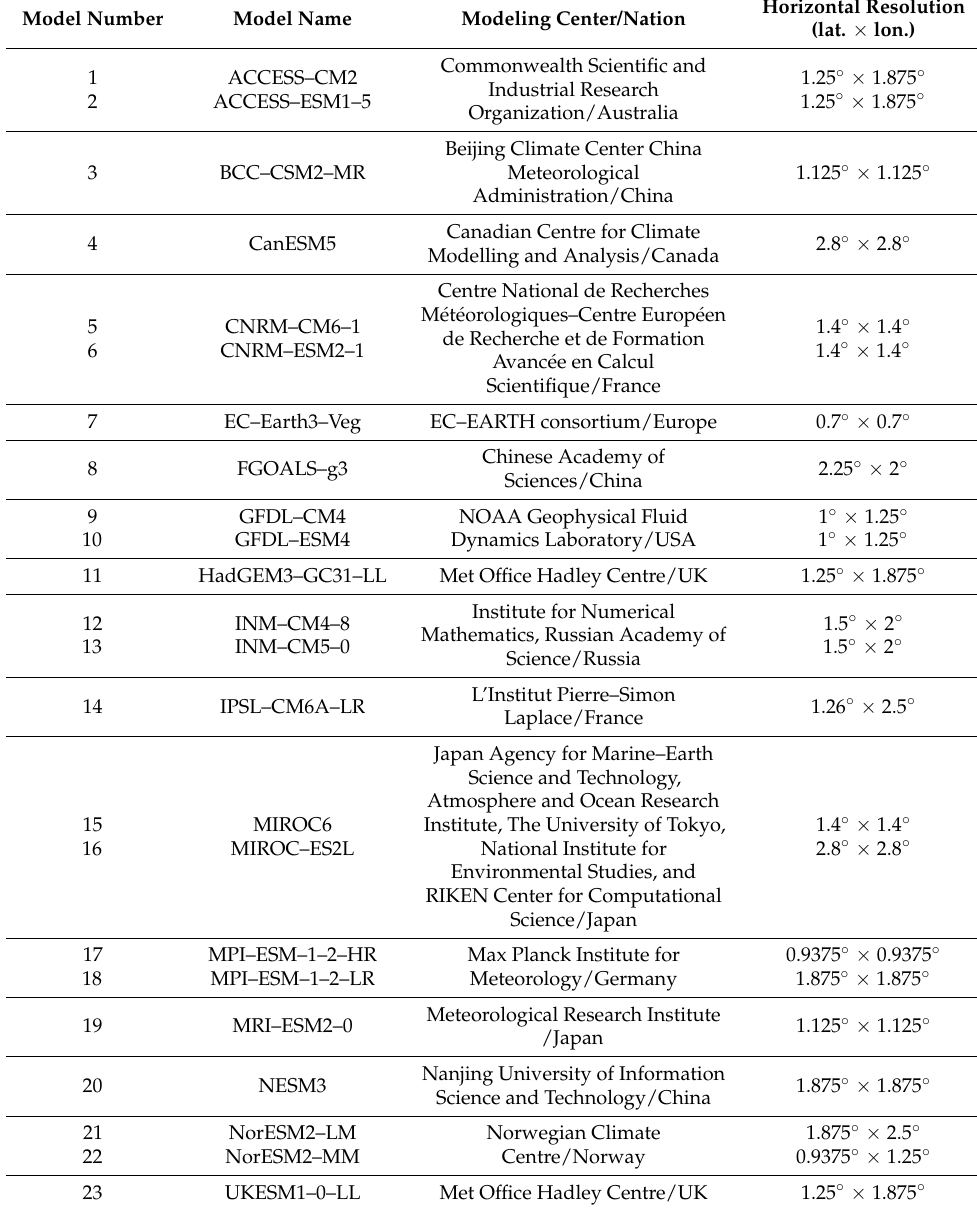
Table 1. List of CMIP6 GCMs and their reporting institutions and countries, and grid increment horizontal